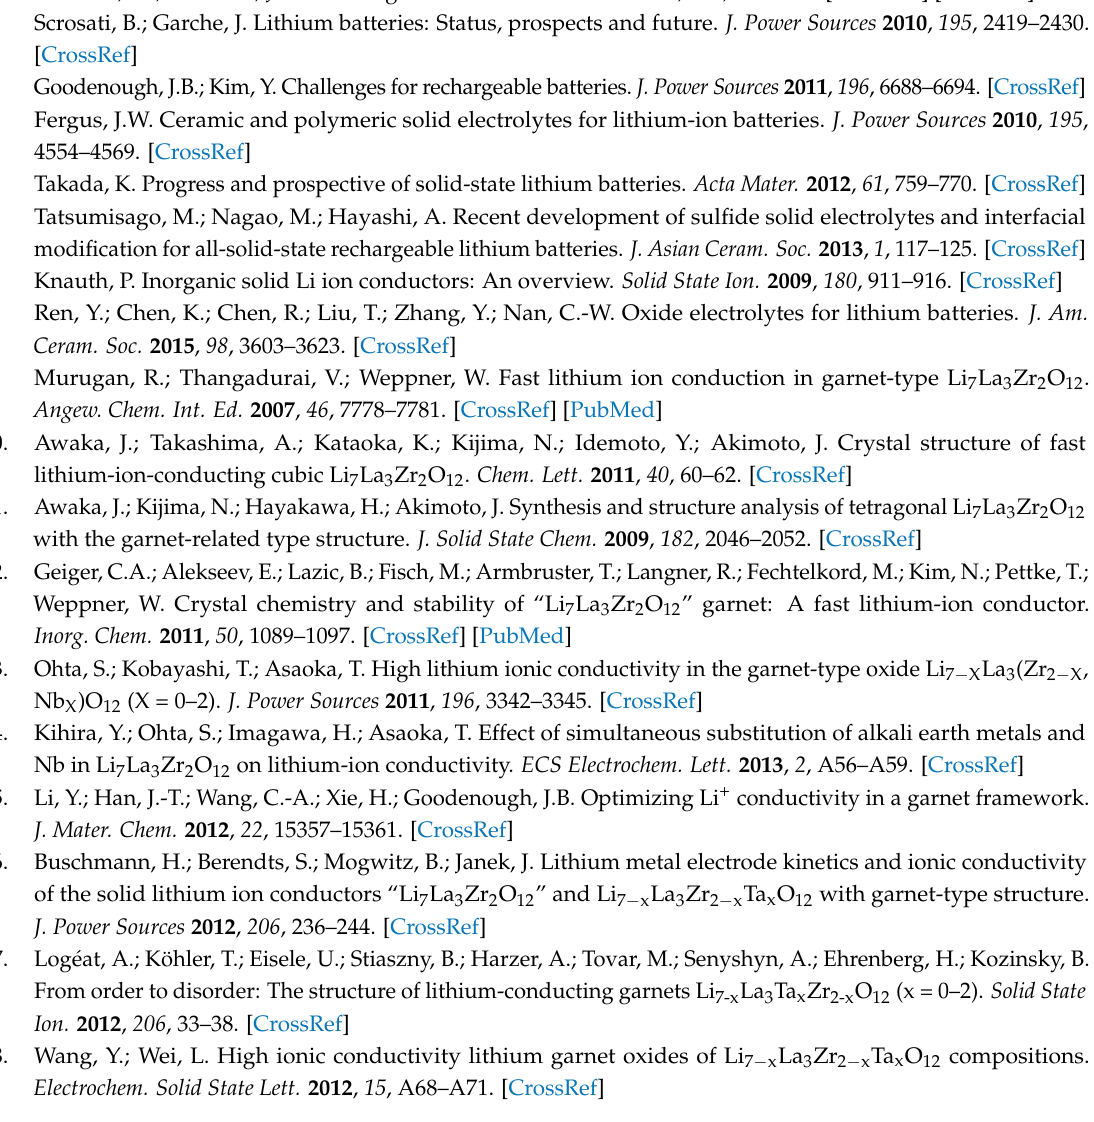
Figure S1: Galvanostatic cycling at 100 ◦ C for Li/LLZT/Li cell with R Li-LLZT = 25 cm 2 at 27 ◦ C and 0.5 cm 2 at 100 ◦ C, Figure S2: Galvanostatic cycling at 25 ◦ C for Li/LLZT/Li cell with R Li-LLZT (27 ◦ C) = 28 cm 2 tested at 0.15 mA cm − 2 for 3 h, Figure S3: Cell voltage at 25 ◦ C and 0.15 mA cm − 2 for 1, 2 and 3 h in Li/LLZT/Li cells as a function of area specific capacity for Li